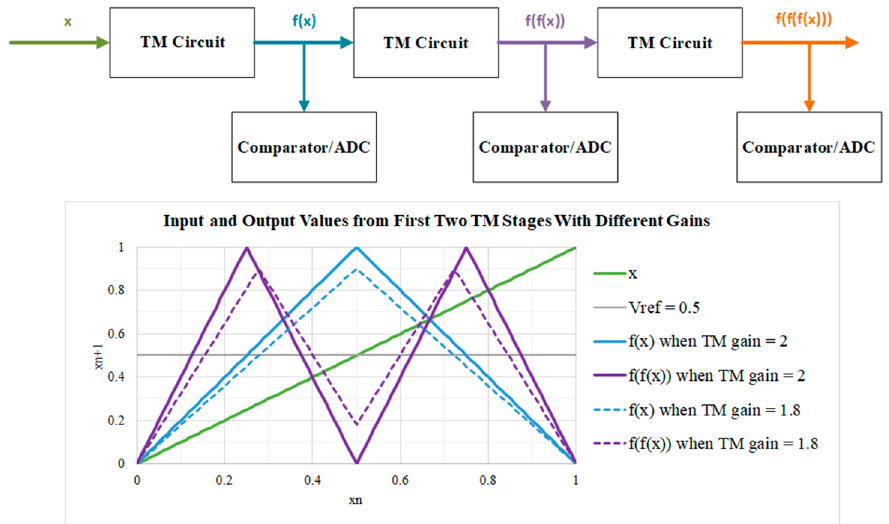
Figure 1. The operation of a series Tent Map (TM)-based analogue-to-digital converter (ADC) and the effects of inherent non-ideal TM gain.